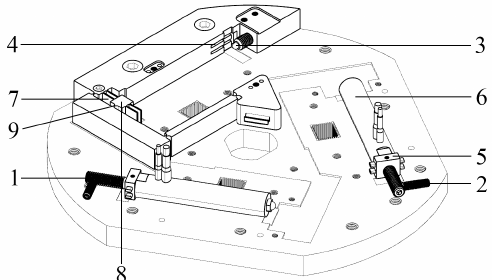
Figure 3. Components of the equivalent active revolute joint R .1: First-level preload screw, 2: second- level preload screw, 3: steel ball, 4: guiding groove of a preload block, 5: preload block, 6: PEA, 7: SaNFH for displacement guiding, 8: input port, and 9: SaNFH for input